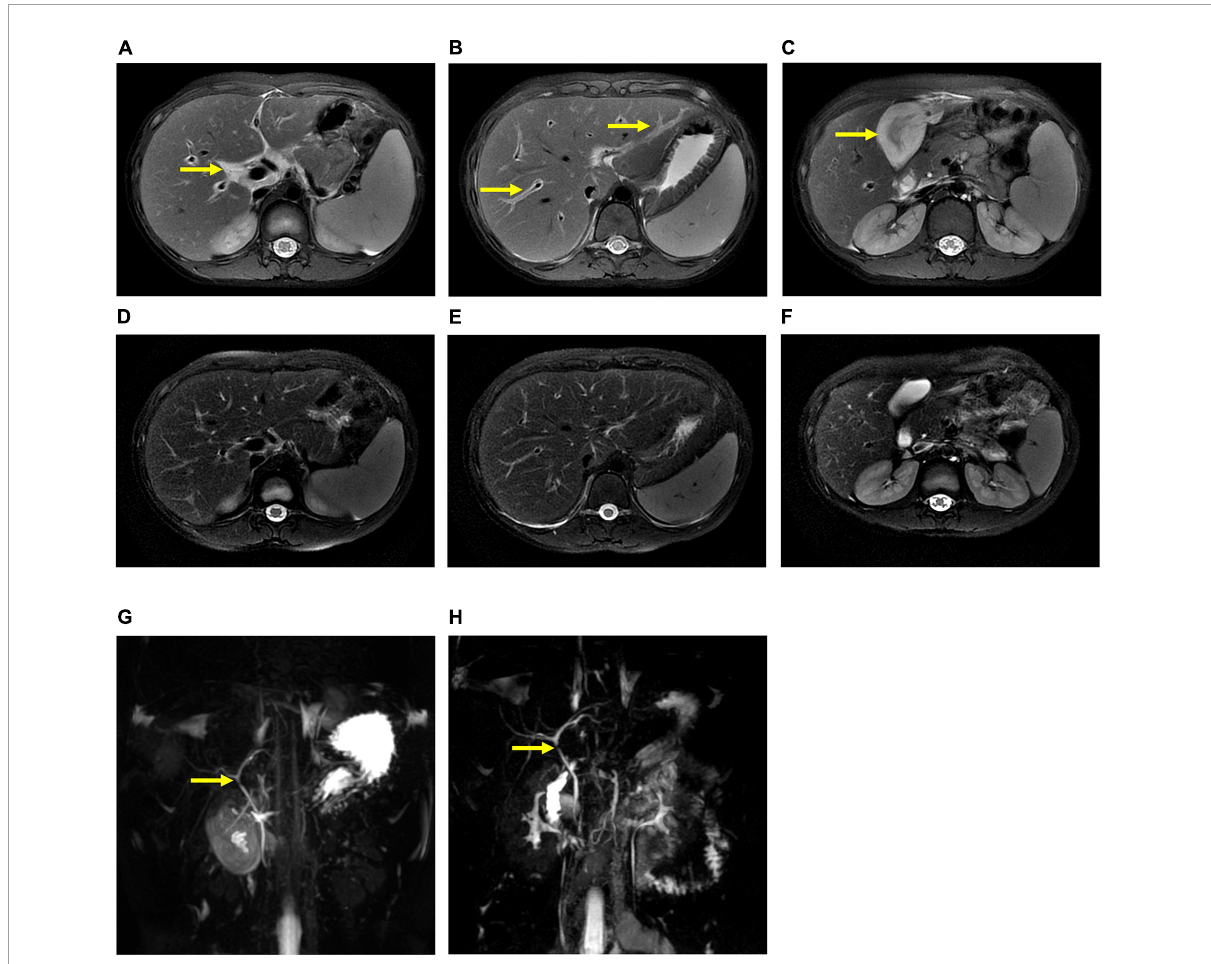
FIGURE1 Magnetic resonance cholangiopancreatography (MRCP) results of the patient. MRCP showed edema of the first porta hepatis and the periportal region (A,B) and thickness of the gallbladder wall (C) at the beginning of treatment (thick arrow), and they were resolved after treatment (D–F) . However, MRCP showed a narrow bile duct that was not relieved during hospitalization (G,H)